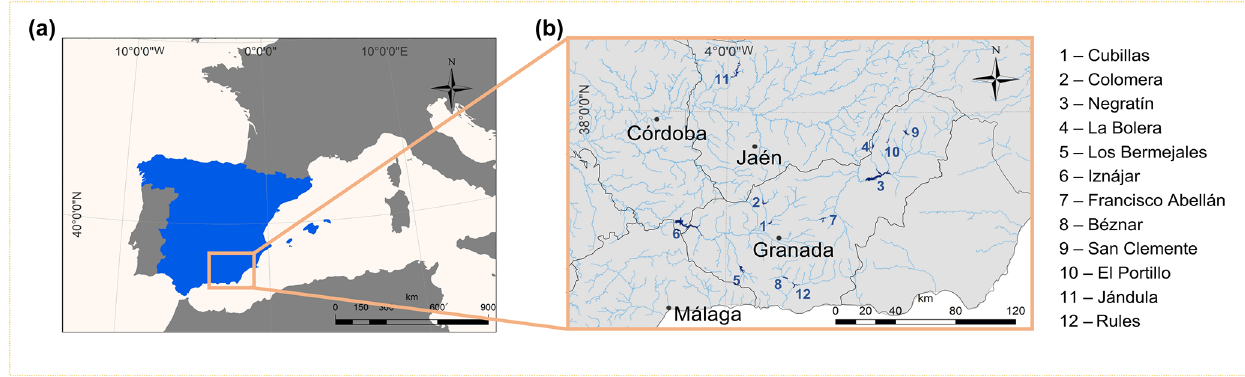
Figure 1. Geographical location of the studied reservoirs. (a) The location area of the studied reservoirs delimited by an orange box in the south of the Iberian Peninsula. (b) Detailed location of the 12 reservoirs with the numbers (1–12) and their corresponding names listed on the side. Geographical coordinates appear in Table 1. We obtained these maps using ArcGIS ® 10.2 software (ESRI, 2012) under the Universidad de Granada license. ©ESRI: ArcGIS, Redlands,